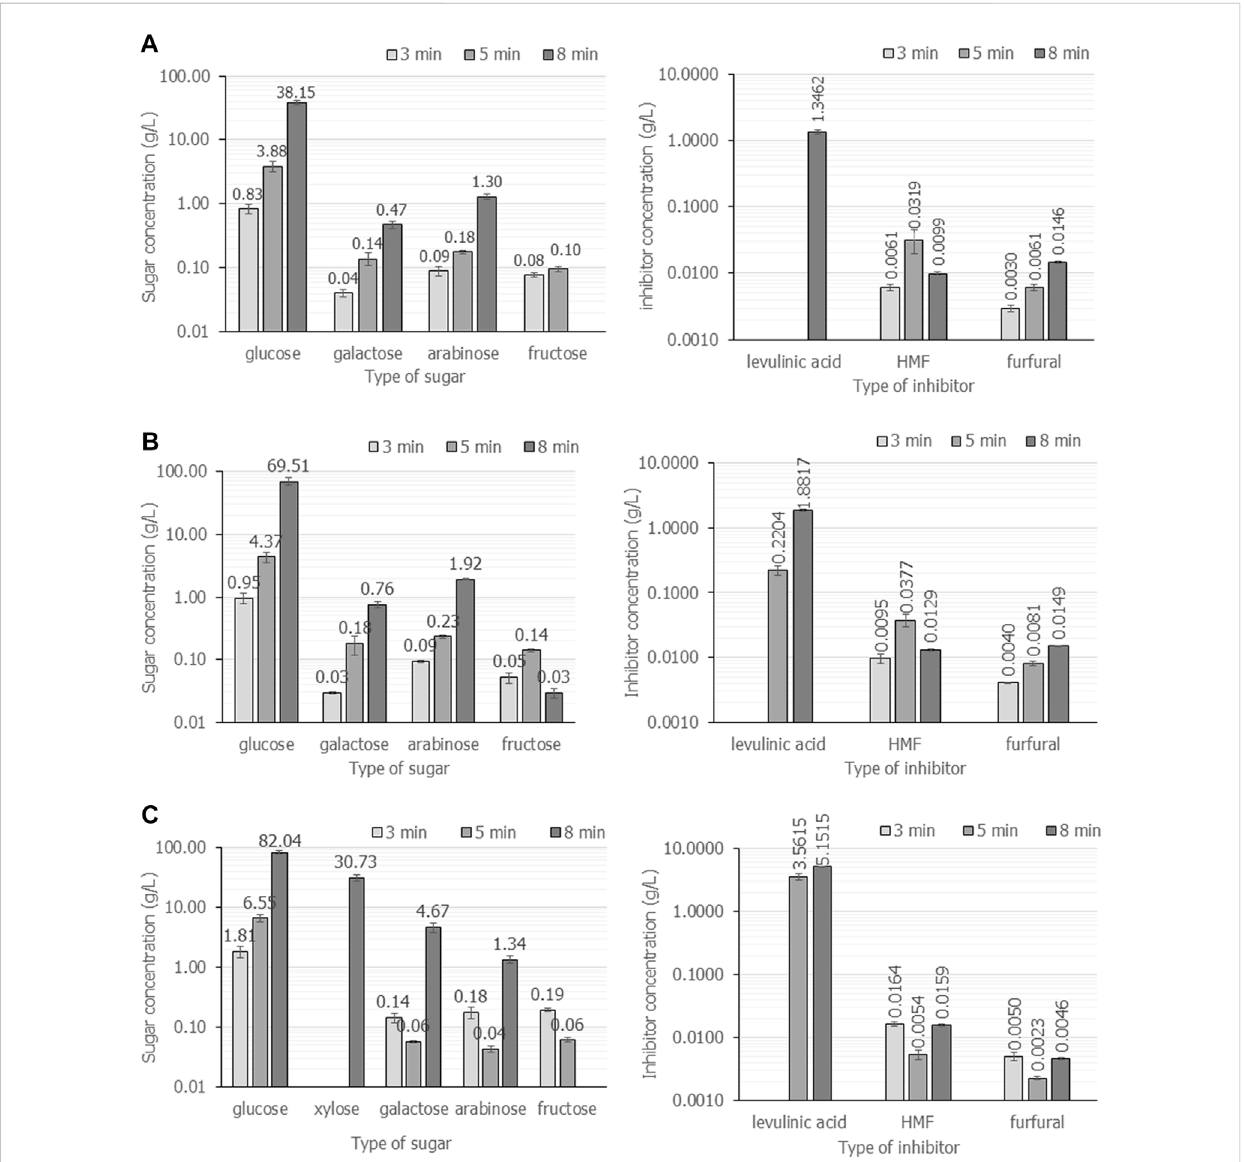
FIGURE 3 The composition of fermentable sugars and inhibitors when cassava pulp was hydrolyzed with liquid-to-solid ratios of 20 mL/g using 2.5% (v/v)